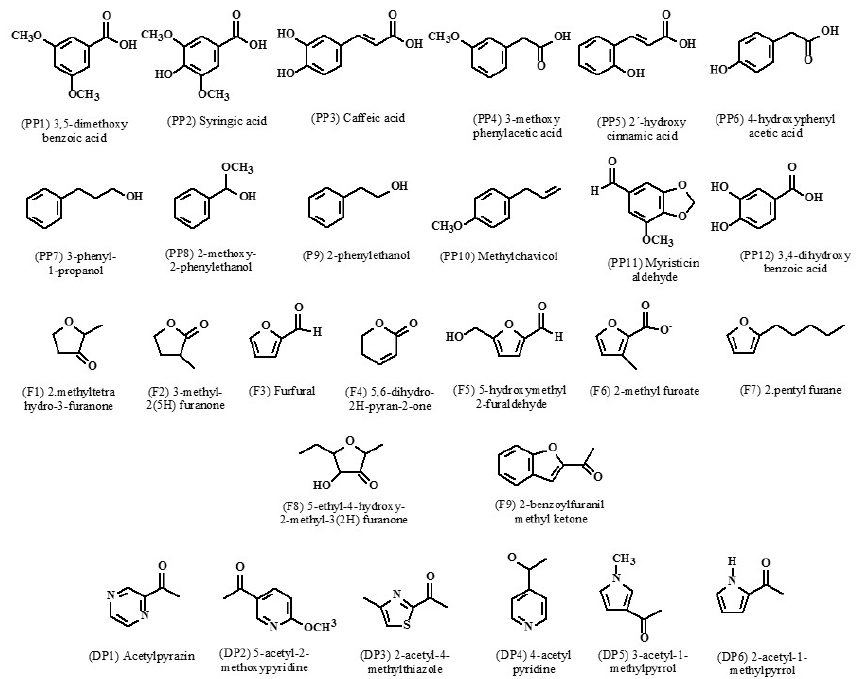
Figure 1. The chemical structures of compounds assayed for biofilm inhibitors.